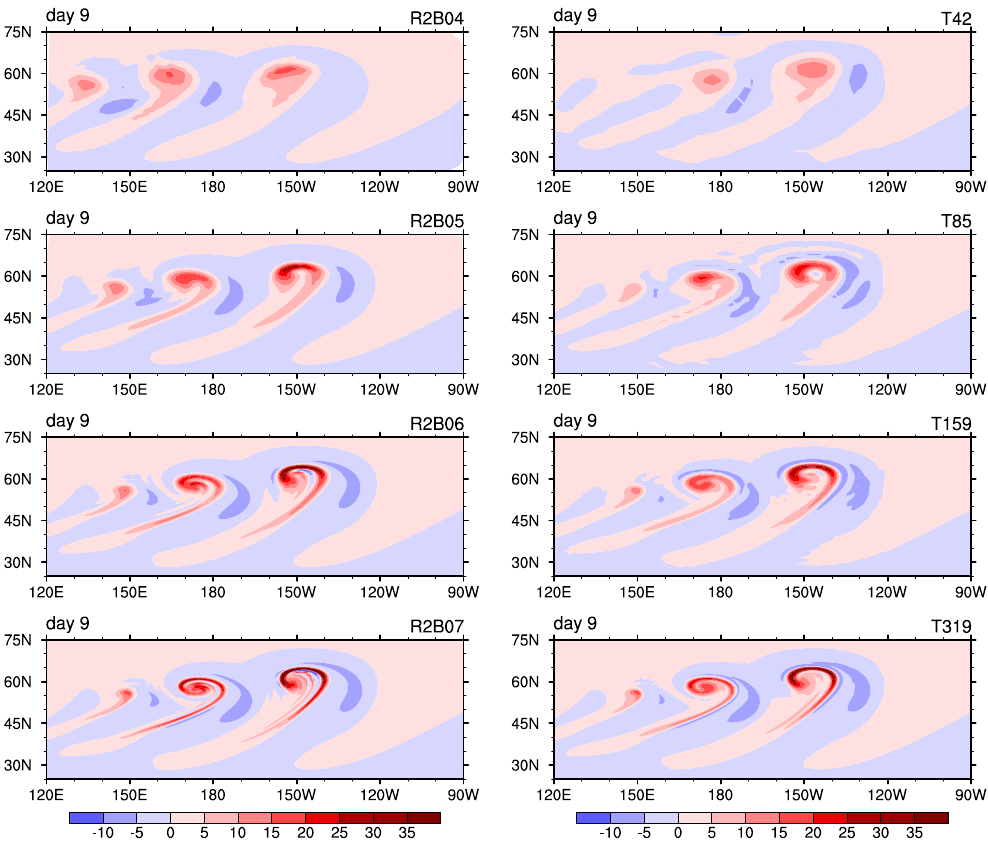
Fig. 9. 850hPa relative vorticity (unit: 10 − 5 s − 1 ) at day 9 in the Jablonowski and Williamson (2006a,b) baroclinic instability test simulated by the new dynamical core (left column) and the spectral transform core of ECHAM (right column) at various horizontal resolutions. Further details can be found in Sect. 6.1.2.